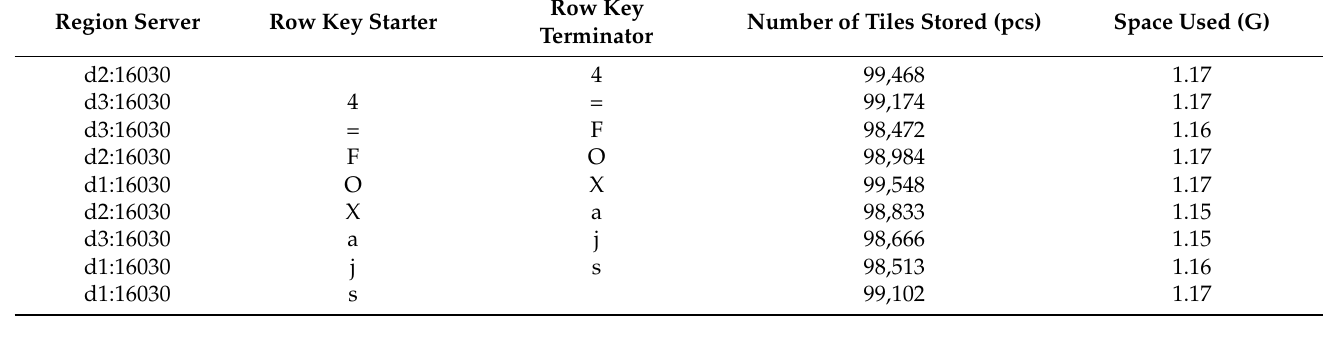
Table 2. Distribution of tile data on region servers. Region Server